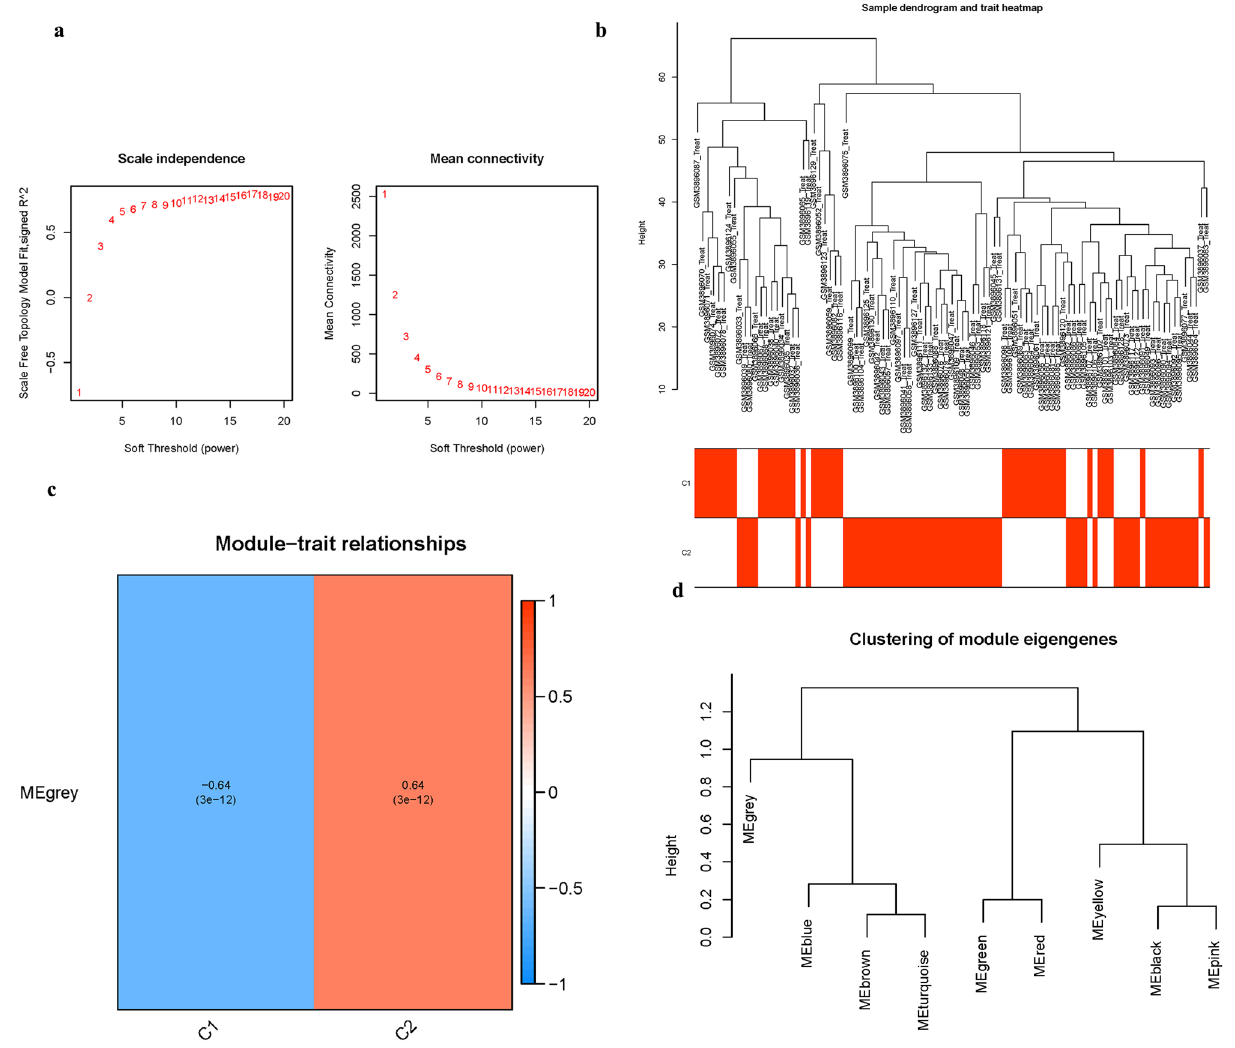
Figure 8. Cluster construction of co-expression modules ( a ) Soft threshold power mean connection and scale- free fitting index analysis. ( b ) Dendrogram clustering ( c ) Heatmap of correlations between module eigengenes and clinical characteristics. ( d ) Gene scatterplot in the grey